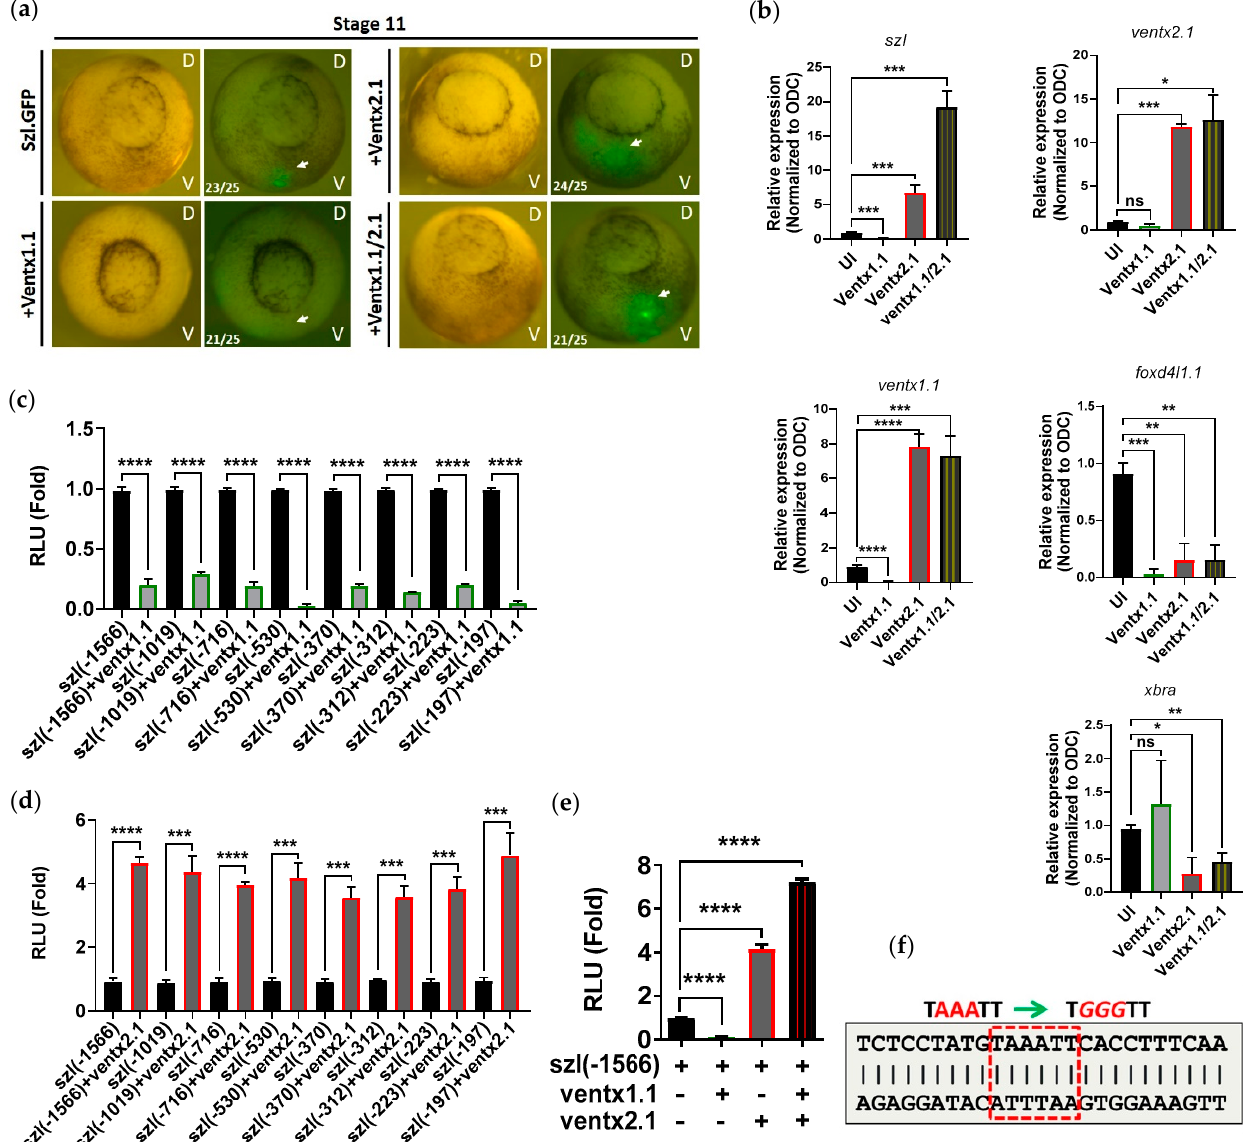
Figure 3. Ventx1.1 and Ventx2.1 mediated szl transcriptional modulation acts as a secondary Bmp4 signaling response: ( a ) Green fluorescence of embryos injected with szl(-1566)-eGFP+ in combination of ventx1.1 and/or ventx2.1 mRNAs at the one-cell stage was observed at stage 11. (25 embryos were injected per sample) ( b ) Embryos were injected with, without or with some combination of ventx1.1/ventx2.1 mRNAs. Animal cap explants (10 AC/sample) were dissected at stage eight and relative expression of ventral specific marker genes, including szl at gastrula stage, through quantita- tive RT-PCR was performed. Ct values were normalized to ODC, a housekeeping gene. ( c ) Serially deleted constructs of the szl promoter were injected with or without ventx1.1 and ( d ) ventx2.1 mR- NAs. Reporter gene activities were analyzed. ( e ) Szl (-1566) -expressing embryos were injected with, without or with some combination of ventx1.1/ventx2.1 mRNAs and analyzed for luciferase activity. ( b – e ) p ≤ 0.05 for *, p ≤ 0.01 for **, p ≤ 0.001 for ***, p ≤ 0.0001 for ****, ns (non-significant) were the assignments for significance. ( f ) Fragment of szl promoter having the putative Ventx response elements (VRE, highlighted within the dashed red box). 2.4. Site-Directed Mutagenesis of One VRE Site on the Szl Promoter Abolishes Ventx1.1 as Well as Ventx2.1 Mediated Szl Transcriptional Regulation